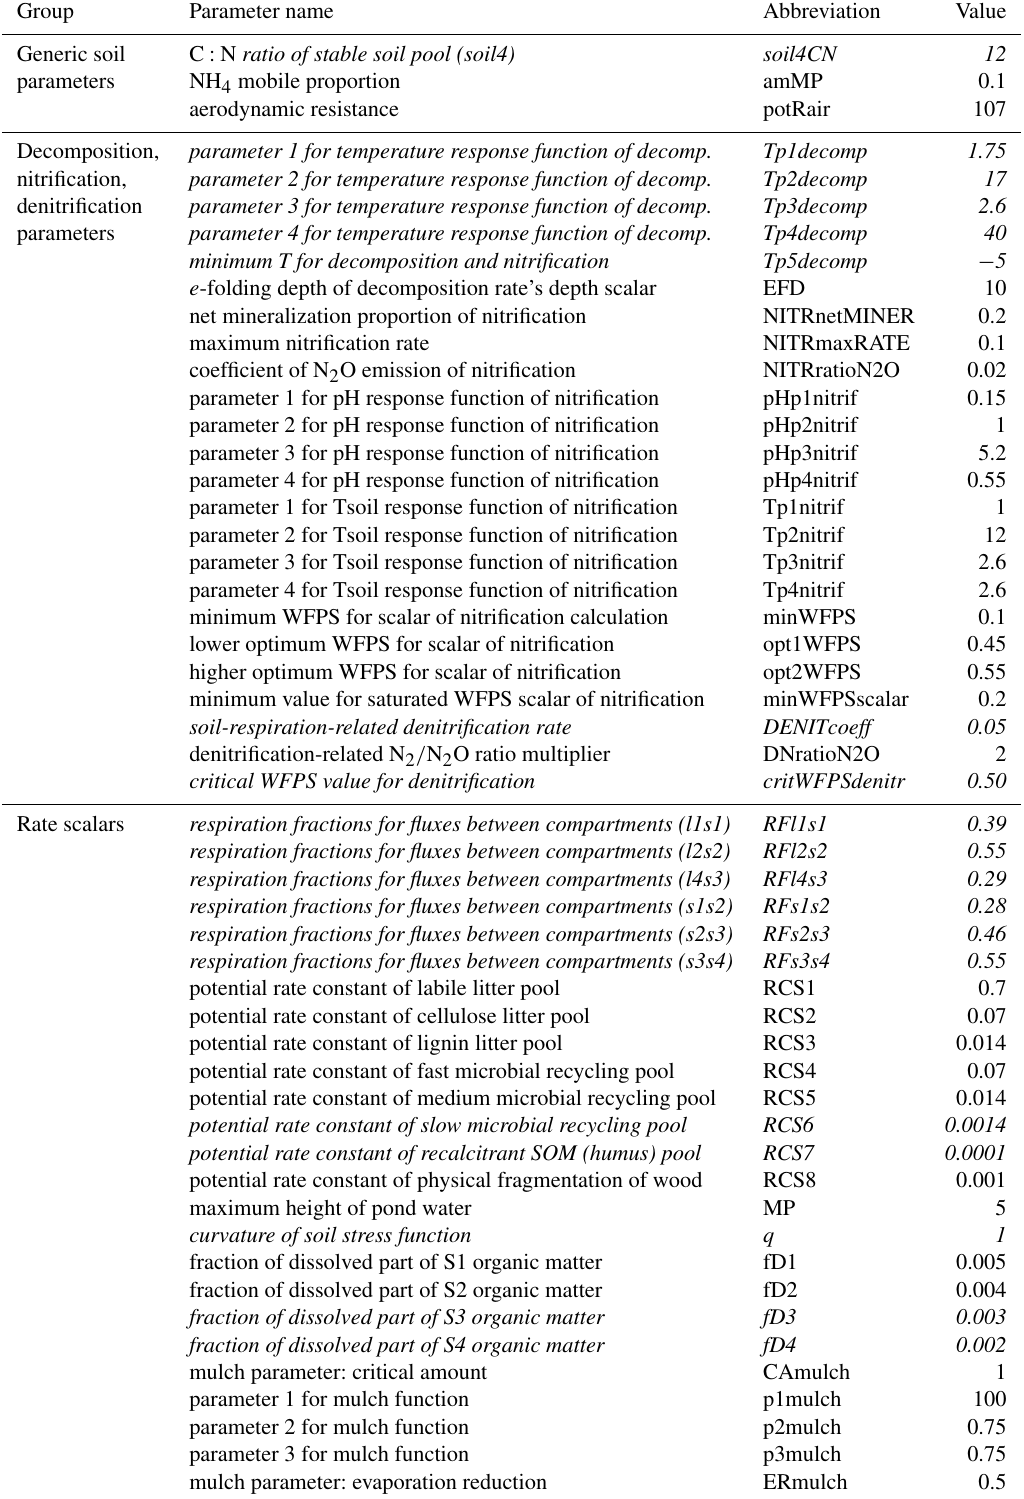
Table 1. Soil parameters of Biome-BGCMuSo v6.2 (referring to SOC simulation) that were used during the sensitivity analysis. The “Value” column shows the originally proposed values (Hidy et al., 2021). See Fig. 4 for an explanation of the compartment names. The parameters that were included in the second phase of the sensitivity analysis are marked with italics (see